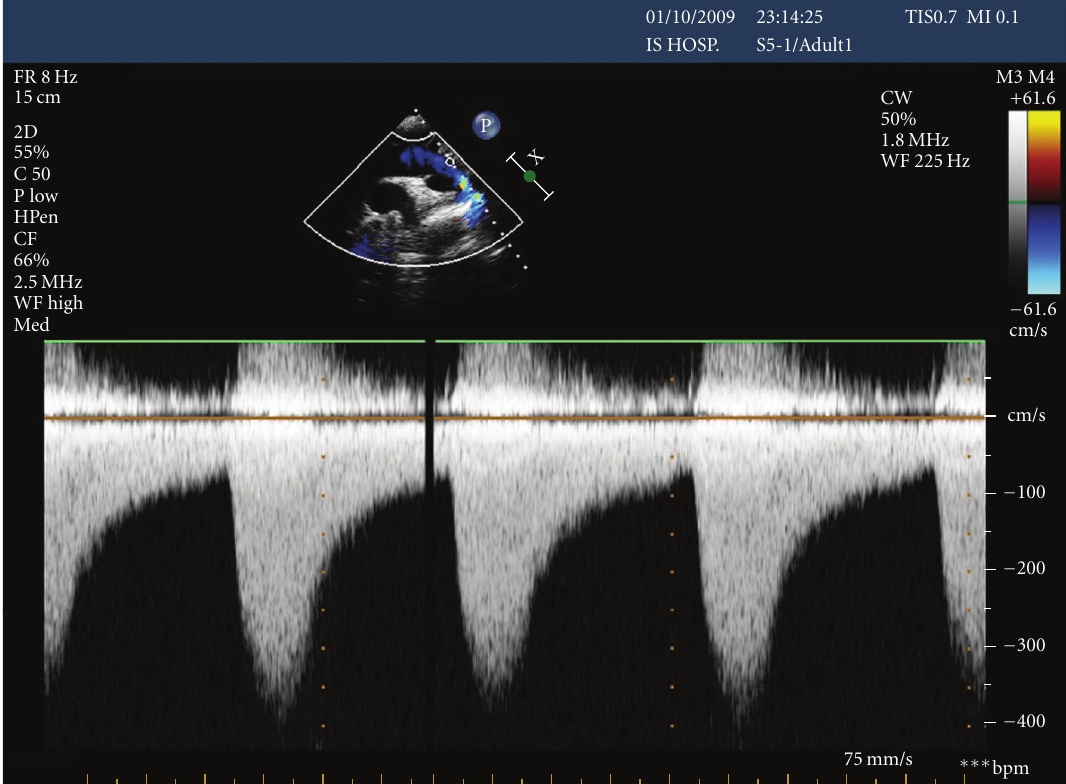
Figure 2: Doppler echocardiography demonstrating the coarctation gradient with a peak flow velocity in the descending aorta of 4.0m/s, comparable to a gradient of